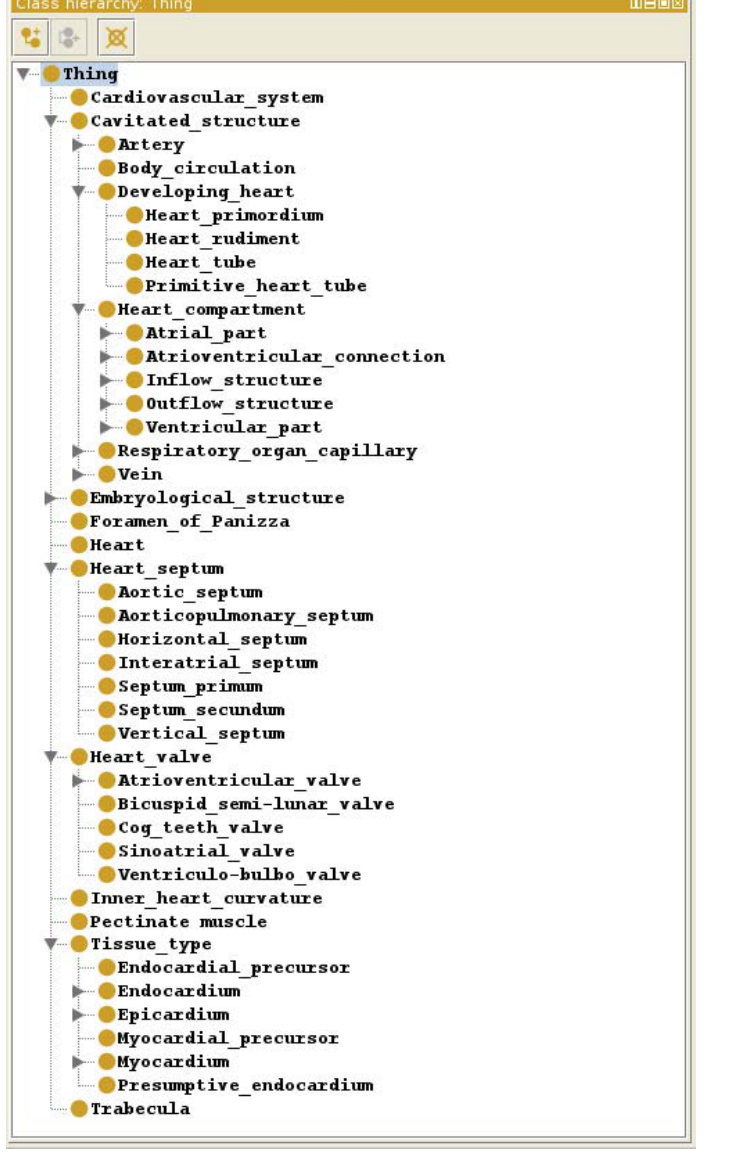
Figure 3: Screen dump of the partially unfolded anatomy ontology in Protégé, showing the main superclasses and several further subdivisions of these; arrows pointing downward indicate the subclasses of a class are shown, arrows pointing to the right indicate the subdivision is not